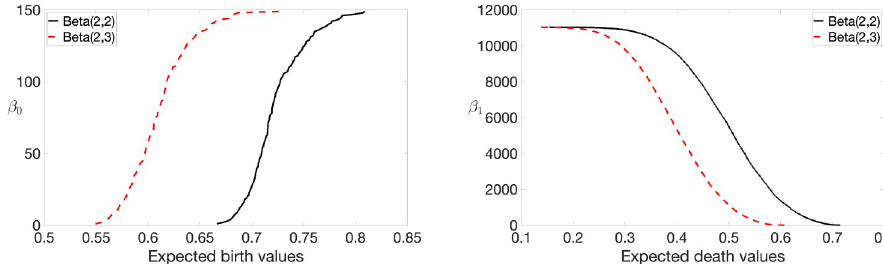
Fig 3. Plots of Betti-0 (left) and Betti-1 (right) curves of random networks with edges drawn from Beta(2, 2) (in dotted red line) and Beta(2, 3) (in solid black line) distributions. The change in distribution affects the topology of a